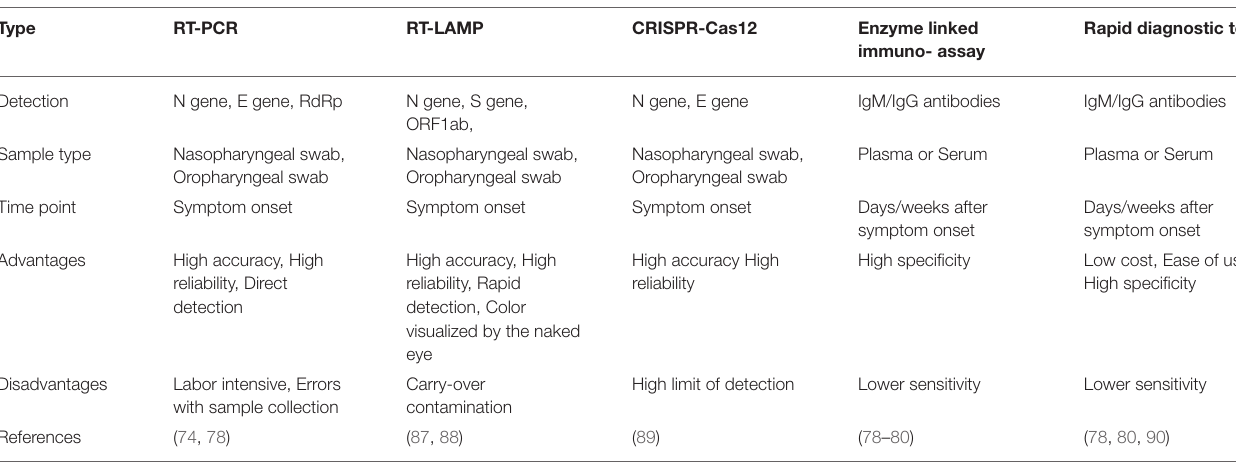
TABLE 3 | Detection methods for